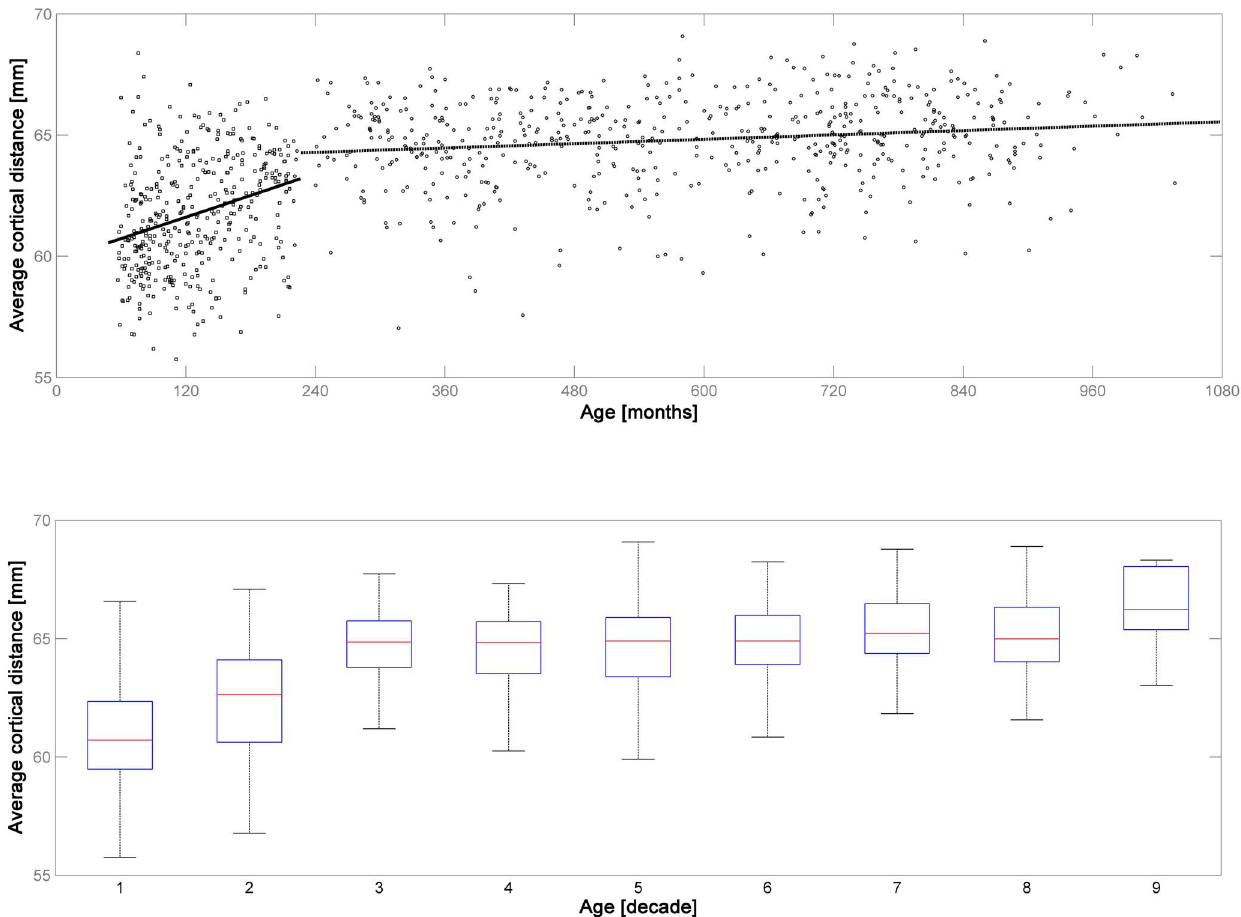
Figure 2. Illustration of the average cortical distance of all subjects in datasets 1 & 2 (structural MRI, n=964). Note steep increase in childhood and adolescence (dataset 1, solid trendline in upper panel) and much more shallow increase in adulthood (dataset 2, dashed trendline in upper panel). Lower panel: illustration of the same results per decade of life. The difference between datasets 1 & 2 and of the first two decades with all other decades is significant (see manuscript for more